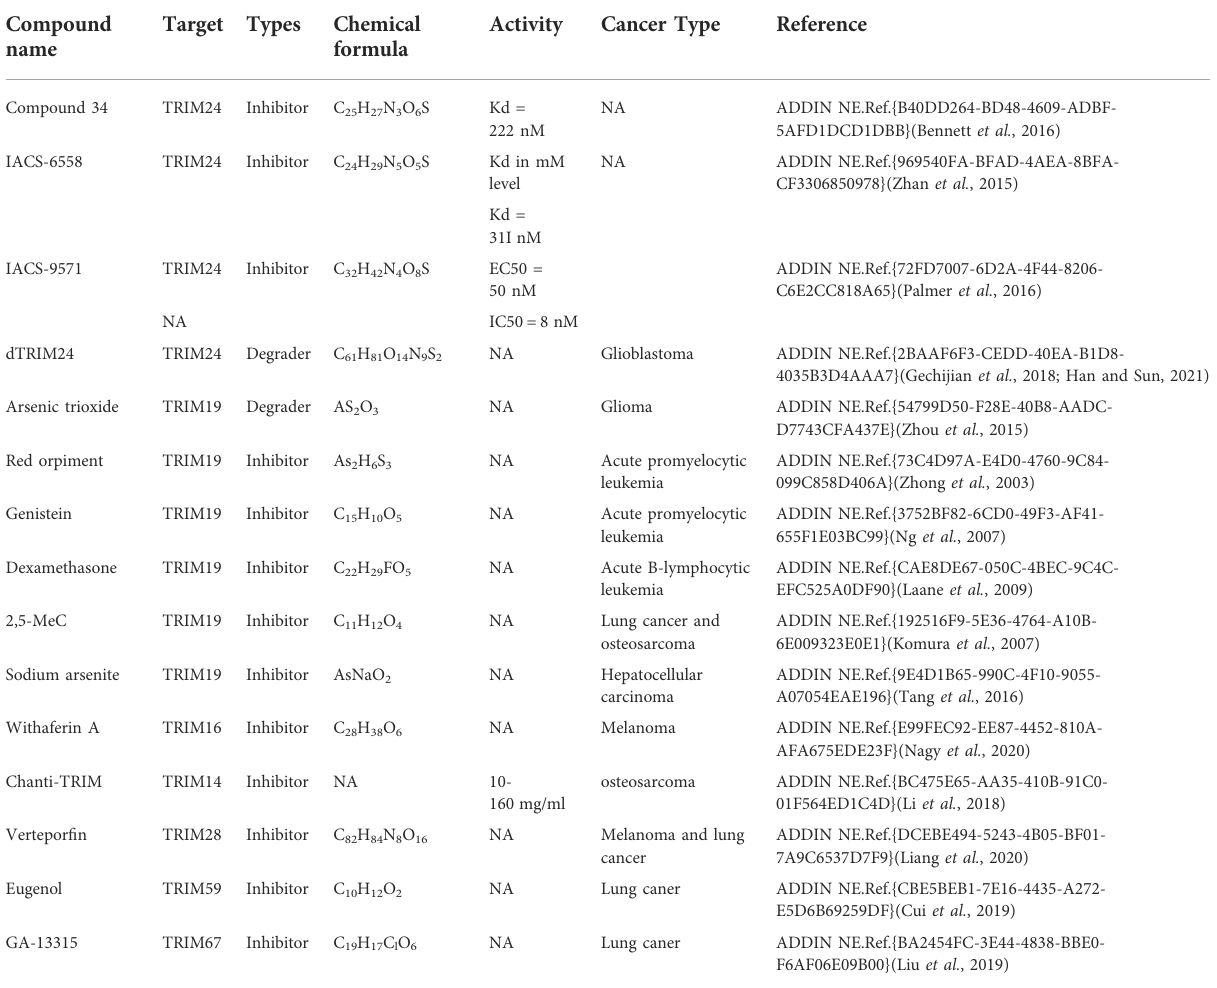
TABLE 6 Representative drug designs targeting TRIM